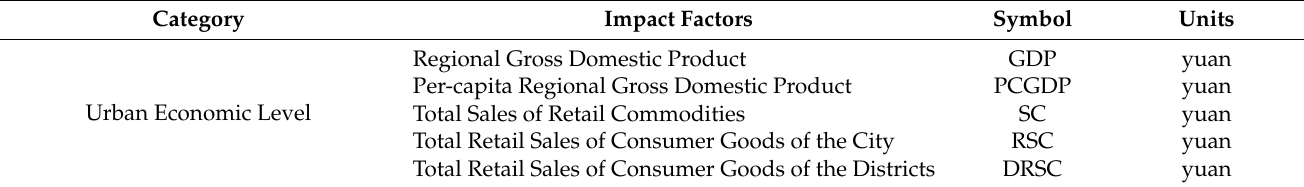
Table A1. The selected impact factors of urban